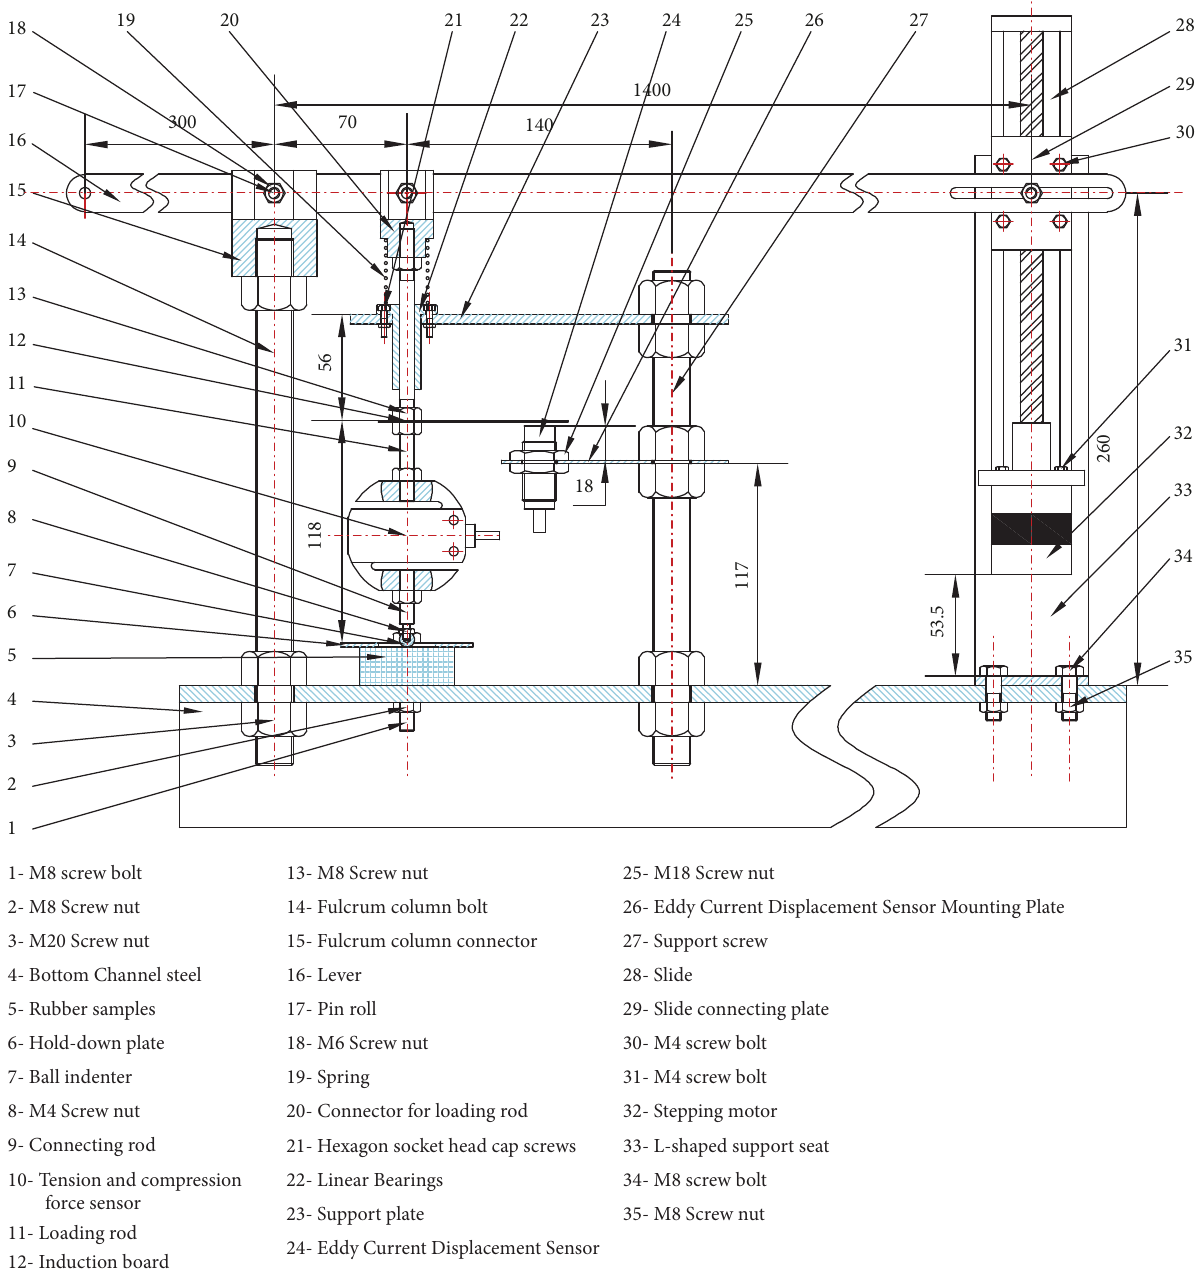
Figure 3: Testing device for relaxation